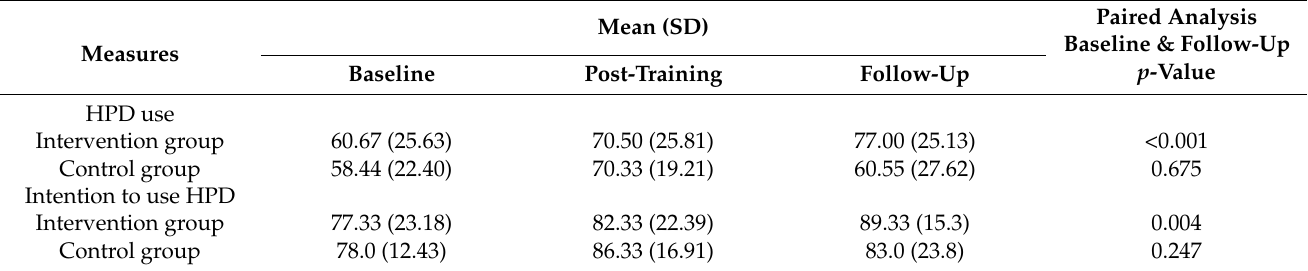
Table 3. Self-reported HPD use and intention to use HPD according to training groups.